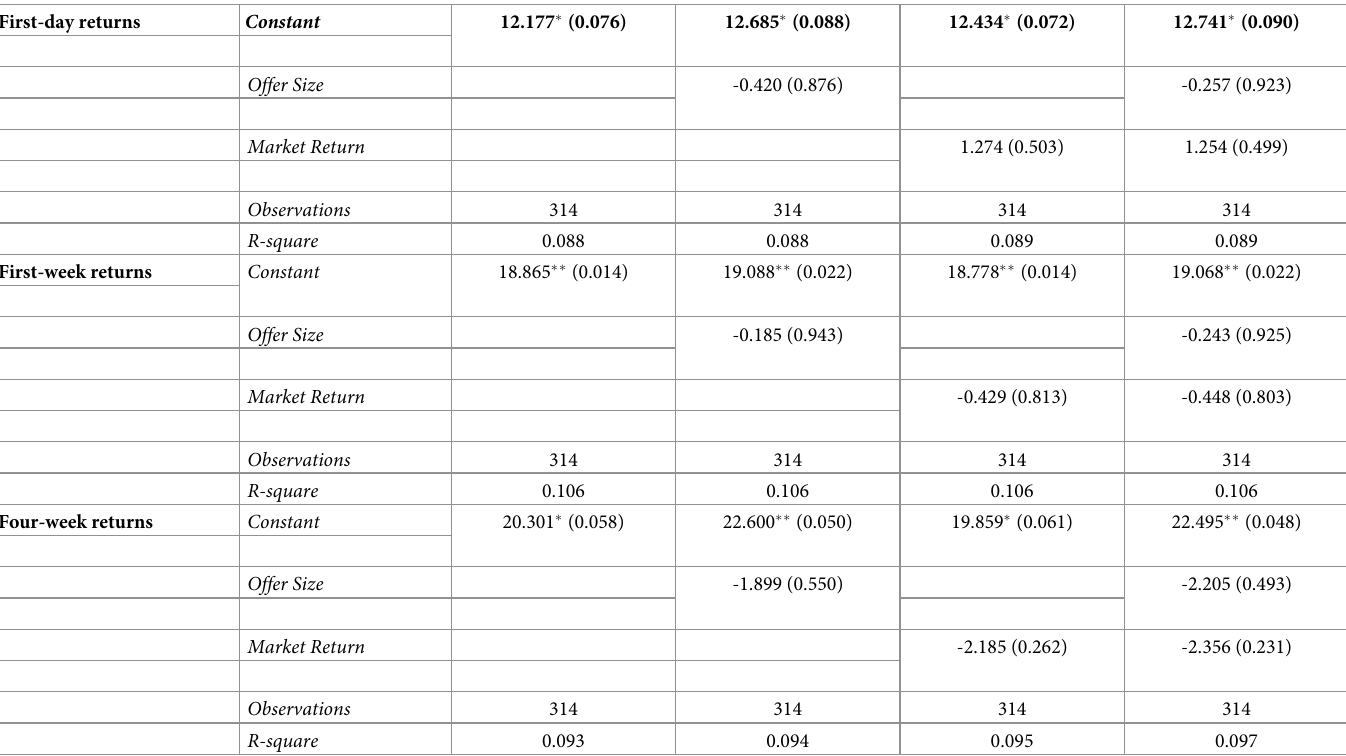
Table 11. Least squares